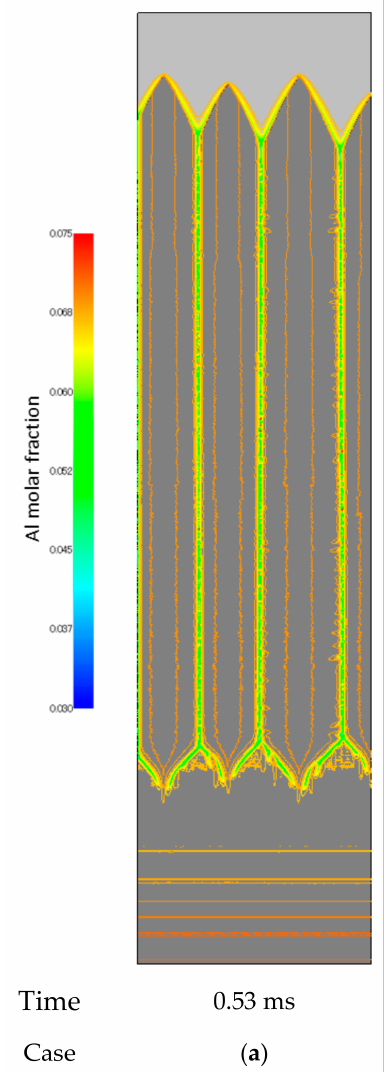
Figure A1. Snapshot of solidification microstructure distributions obtained by the non-equilibrium MPFM at Al concentrations (molar fraction) of ( a ) 5 × 10 5 K/s and 5 × 10 6 K/m using twice the number of horizontal grid